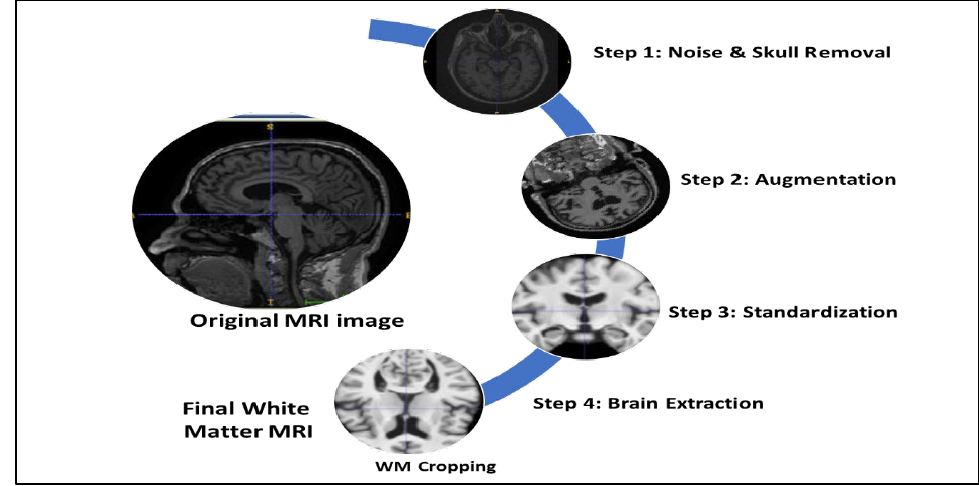
Figure 3. The original MRI processing method. Pictures from top to bottom are MRI after removing the skull, flip, and rotation; image registration; the White Matter (WM) extraction MRI extraction.